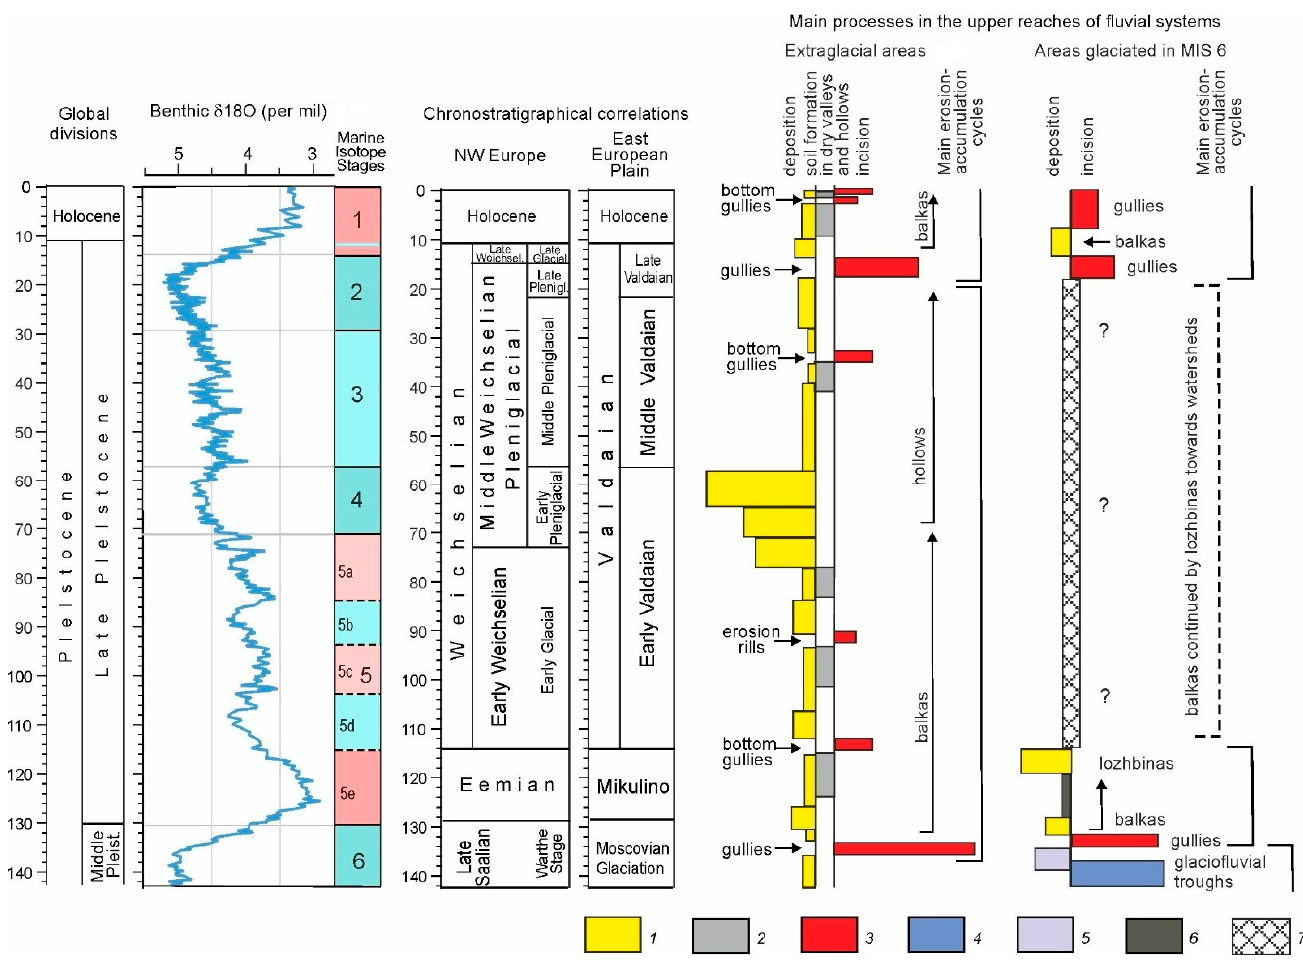
Figure 14. A comparison of the evolution of the upper reaches of fluvial systems in the regions of the East European Plain glaciated and non-glaciated [8] during MIS 6 (=Moscovian/Late Saalian glaciation). Keys: 1—predominant accumulation in the small erosional forms, 2—soil